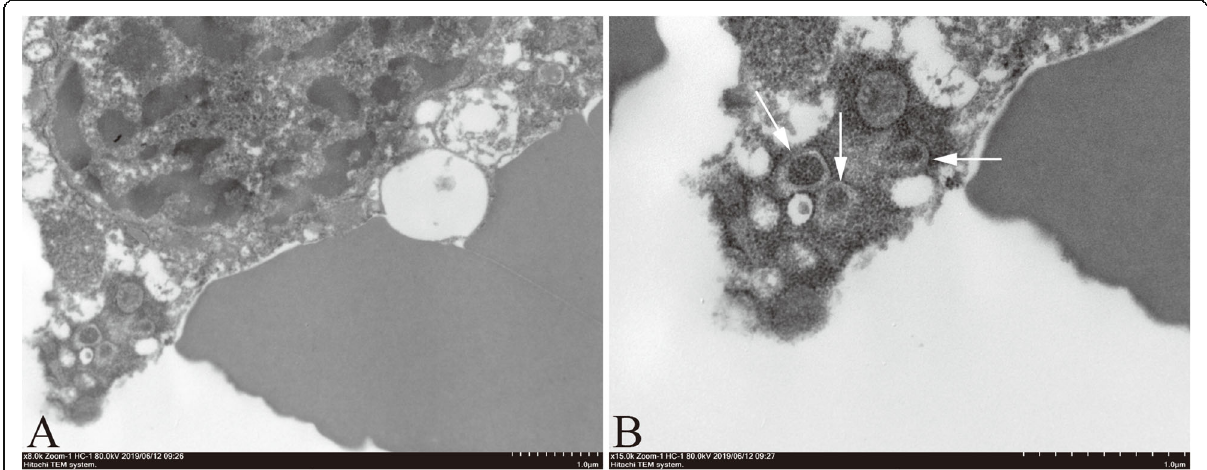
Fig. 2 Electron photomicrograph of SOX11 + large cell carcinoma with neuroendocrine morphology. A, The tumor cell is rich in euchromatin and has distinct nucleolus with large nuclei (uranyl acetate and lead citrate, × 5000). B, Cytoplasmic dense-core (neurosecretory) granules surrounded by a transparent envelope (synaptic protein) within the cytoplasm are observed (As indicated by the white arrow) (uranyl acetate and lead citrate, ×